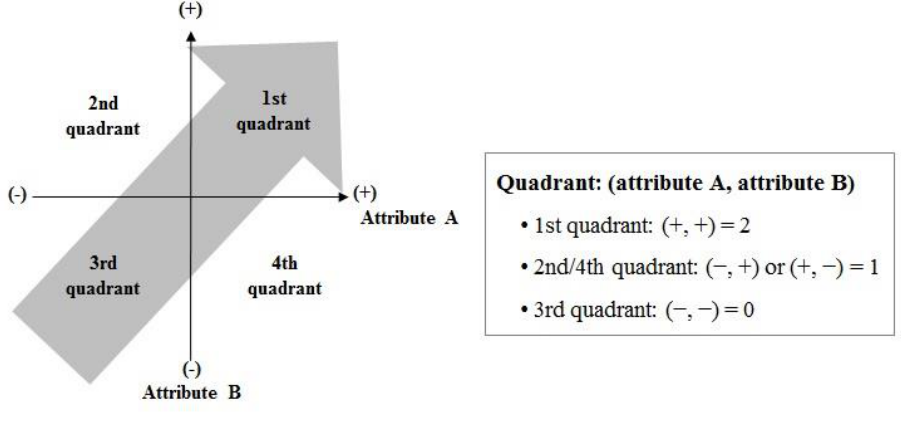
Figure 2. Priority determination graph .